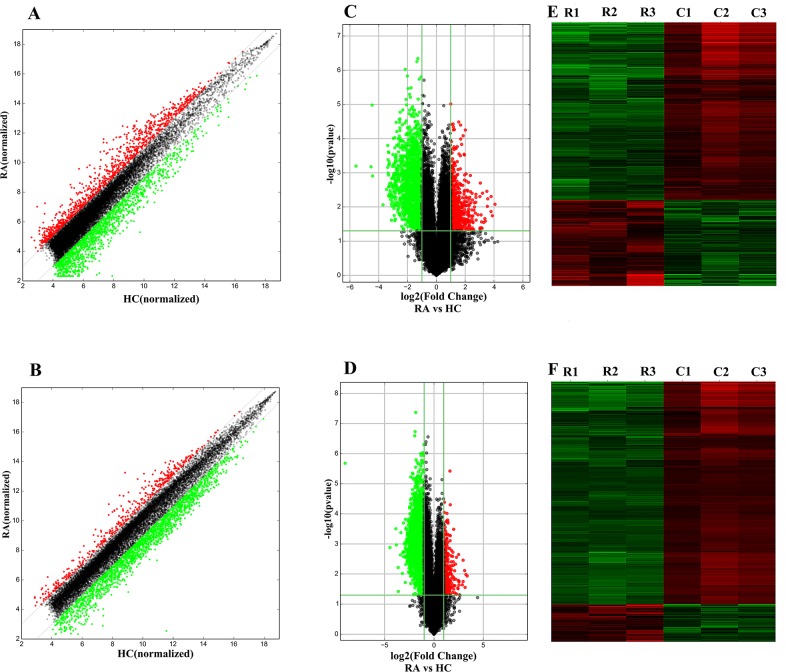
Expression profiles of lncRNAs(A/C/E) and mRNAs(B/D/F) in female RA patients.(A and B) Scatter-plot of differences in the lncRNA and mRNA expression. The X and Y axes are the mean normalized signal values (log2 scaled). The gray lines are 2-fold change lines. (C and D) Volcano plot of differentially expressed lncRNAs and mRNAs. The horizontal green line represents a P-value of 0.05, and vertical green lines represent 2.0-fold changes up and down. X axes are the fold change values (log2 scaled), and Y axes are the P-values (log10 scaled). (E) and (F) Hierarchical clustering analysis of lncRNAs and mRNAs with expression changes greater than two-fold and P value <0.05. RA patient group: R1, R2, R3; Healthy control group: C1, C2, C3. Red and green colors represent up- and downregulated genes, respectively.